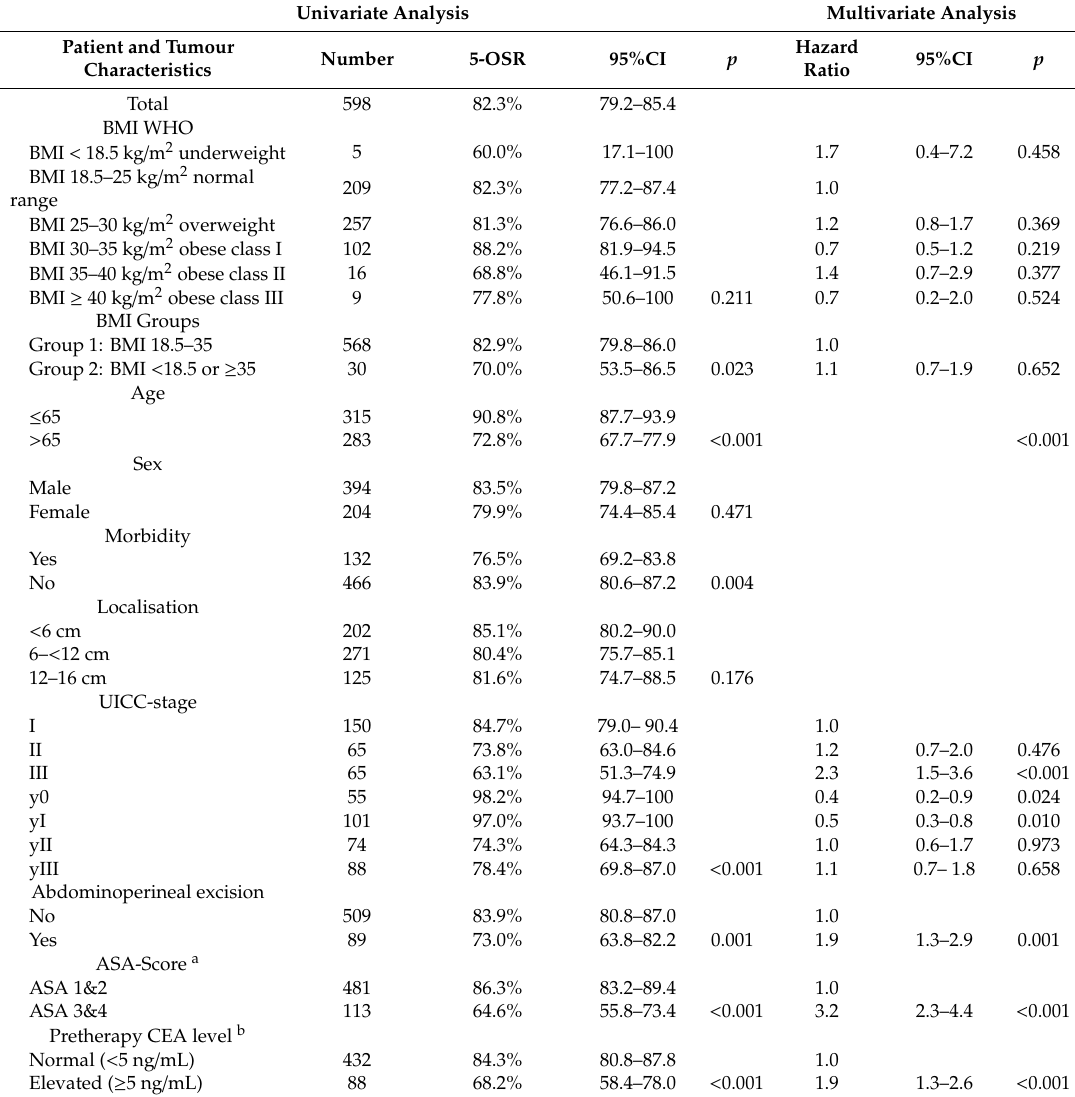
Table 6. 5-year overall survival for 598